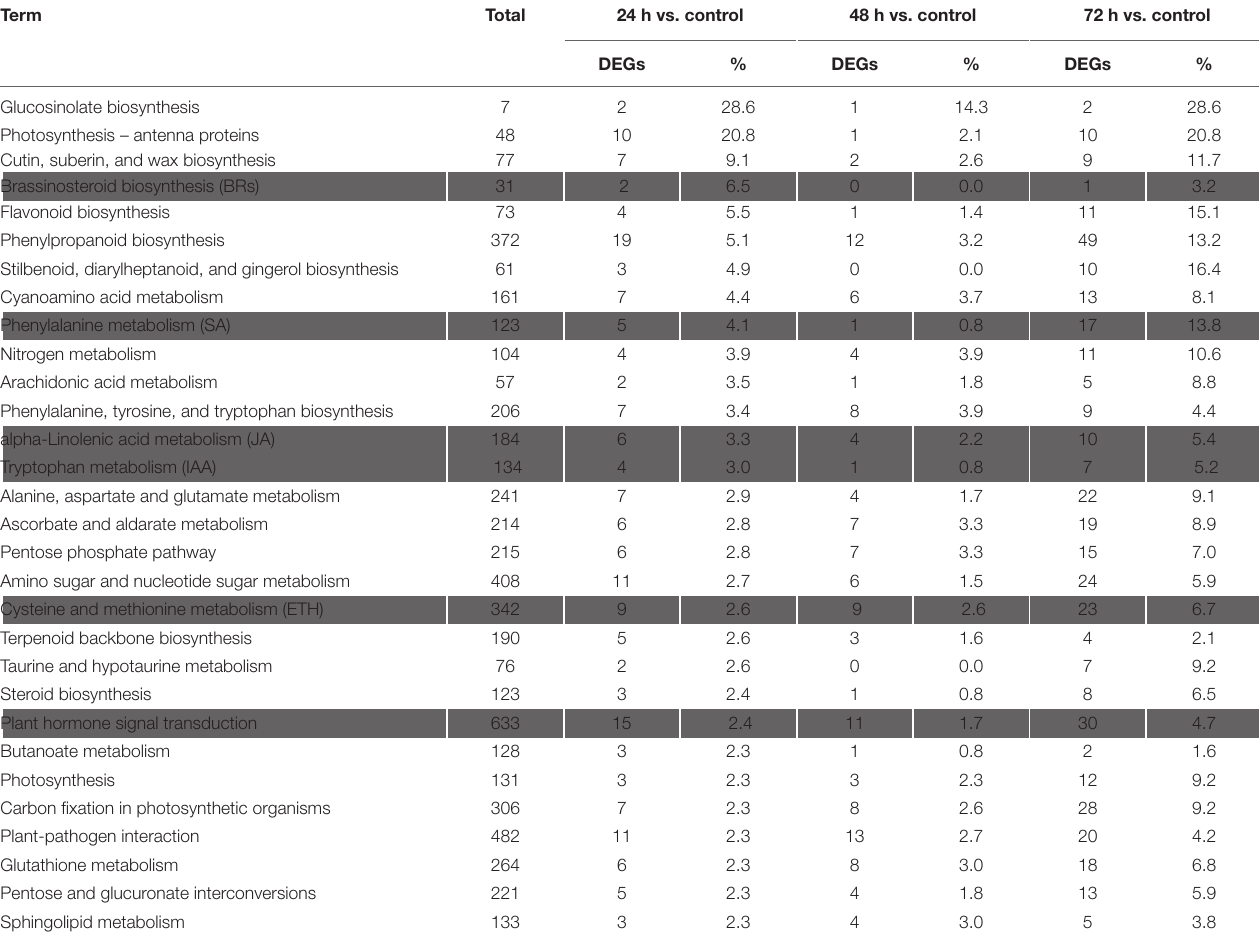
TABLE 1 | Top 30 KEGG pathways based on the percentage of DEGs in 24 h vs. control. Term